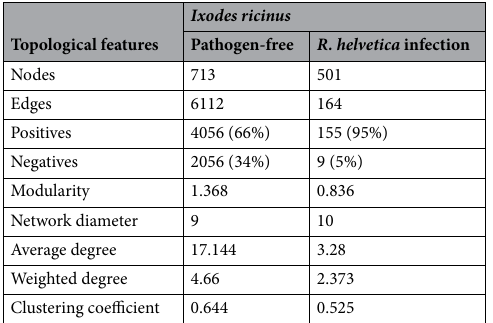
Table 1. Topological features of the taxonomic networks with and without R. helvetica presence.